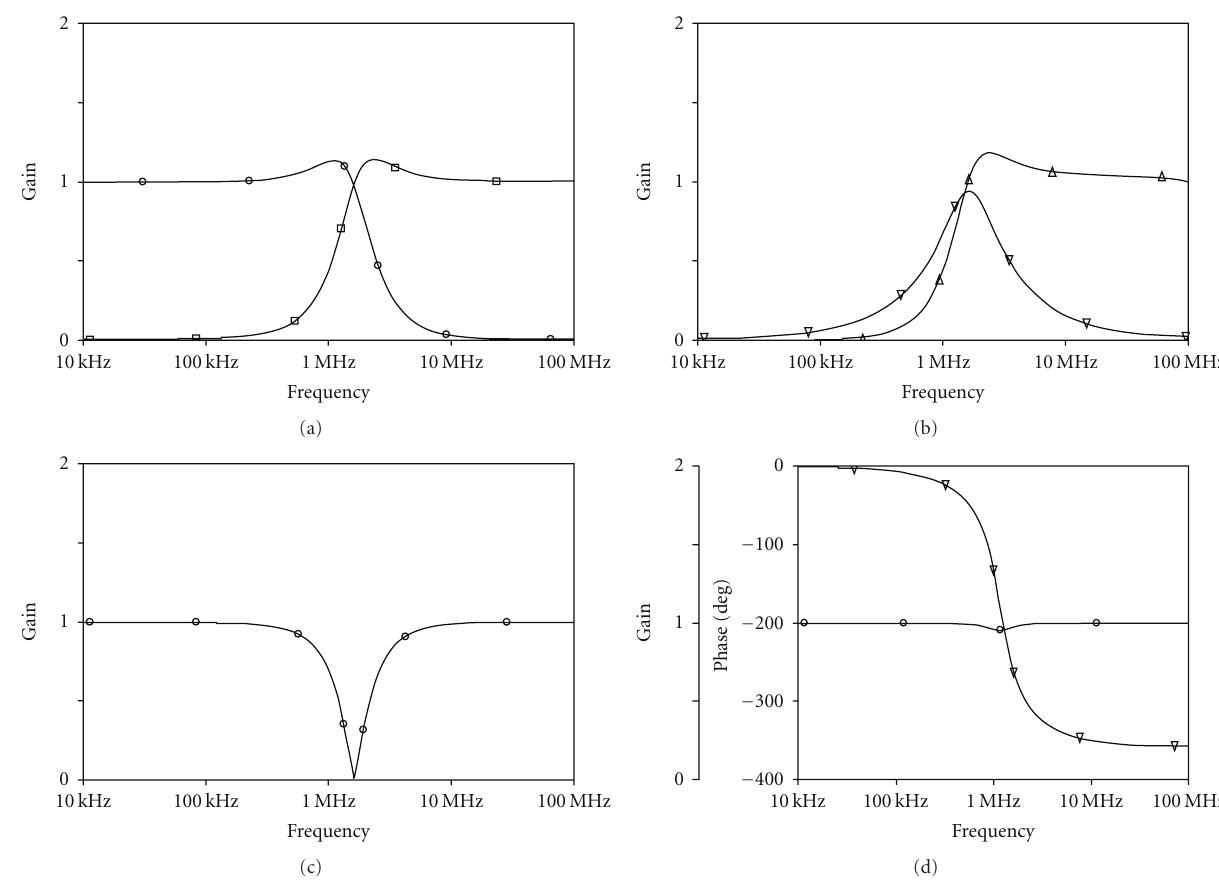
Figure 4: Simulated response of the proposed universal voltage-mode filter: (a) high-pass and low-pass, (b) high-pass and band-Pass, (c) notch, (d) all pass.